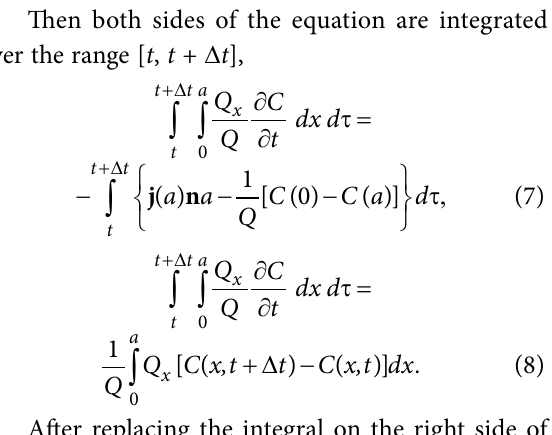
Fig. 2. Flow diagram of the inhibitor in the concrete. Description in